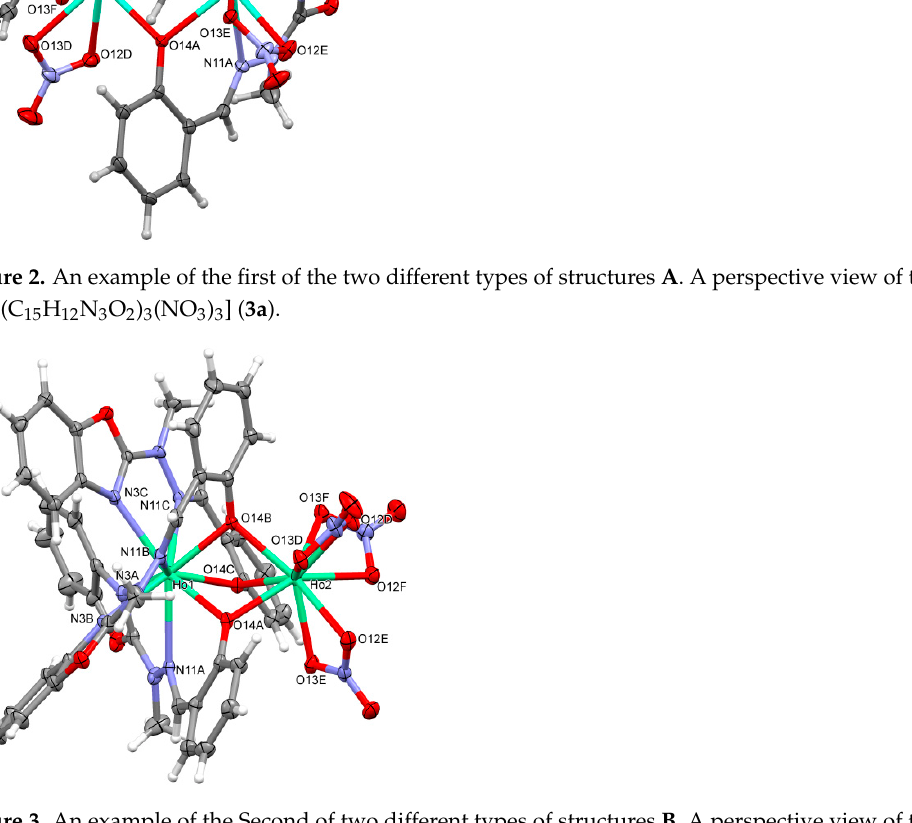
Figure 3. An example of the Second of two different types of structures B . A perspective view of the [Ho 2 (C 15 H 12 N 3 O 2 ) 3 (NO 3 ) 3 ] ( 5 ).